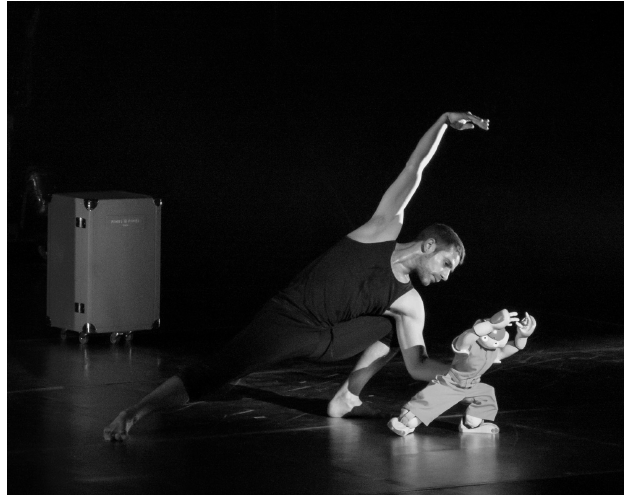
Figure 1. Rehearsing the Pas-des-deux of Blanca Li’s Robot! before performing in Mâcon,